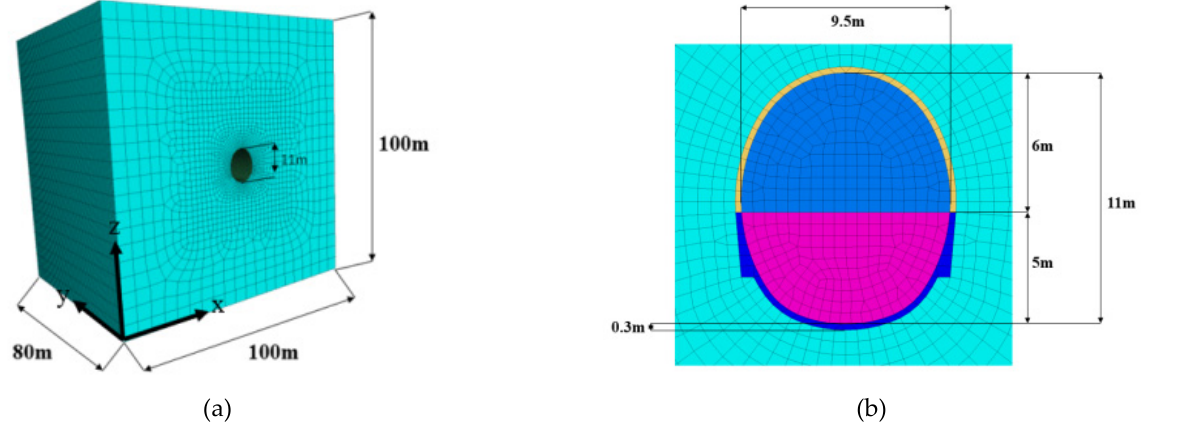
Figure 7. Diagrams showing the overall model and the tunnel section: ( a ) model size; ( b ) tunnel cross-section size.